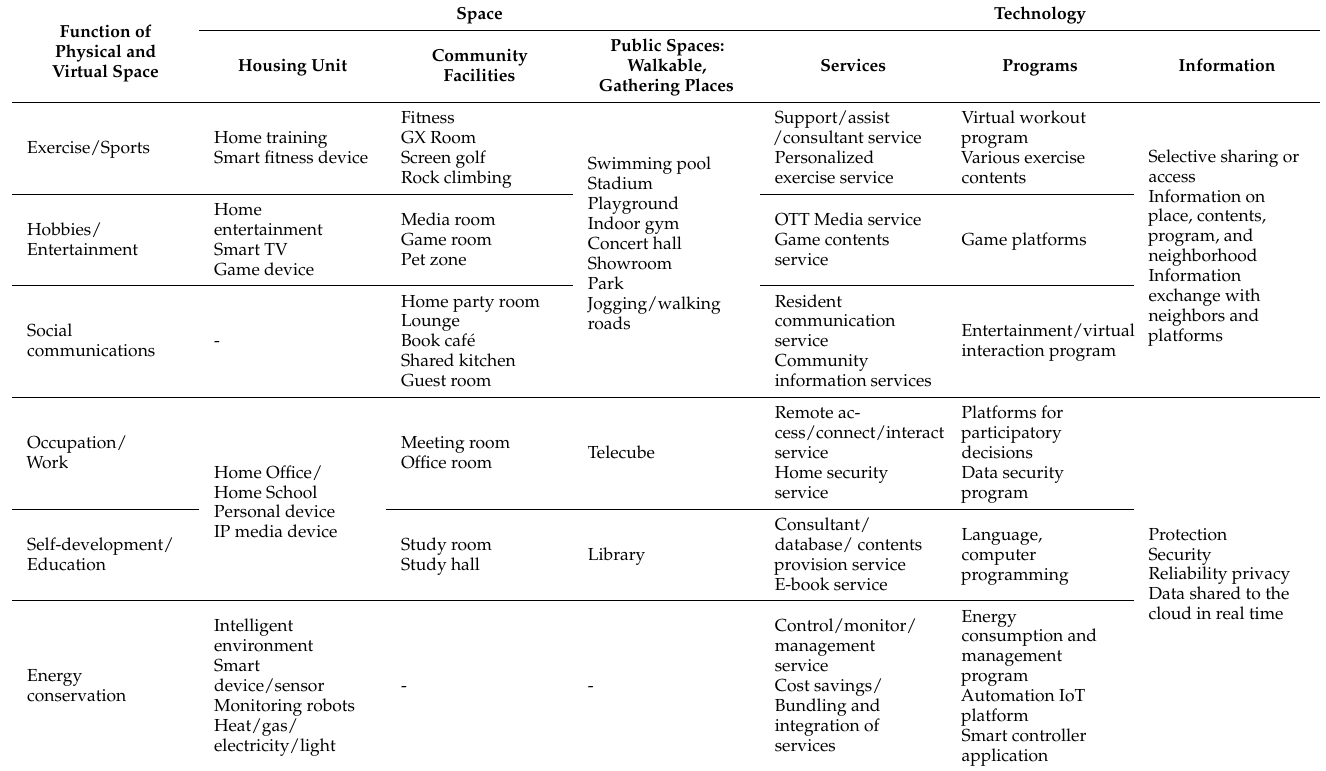
Table 9. Smart Home for The Wellness of One- and Two-person